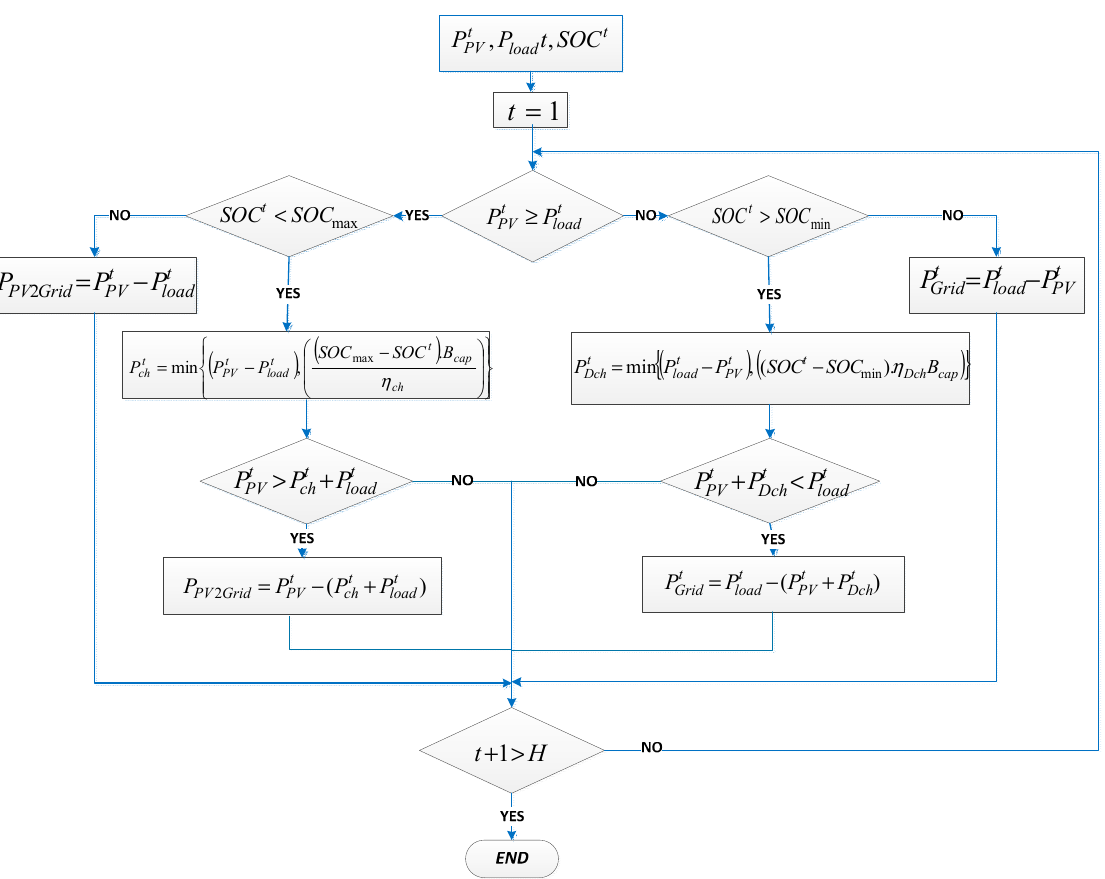
Figure 3. Flowchart of the power dispatch strategy.